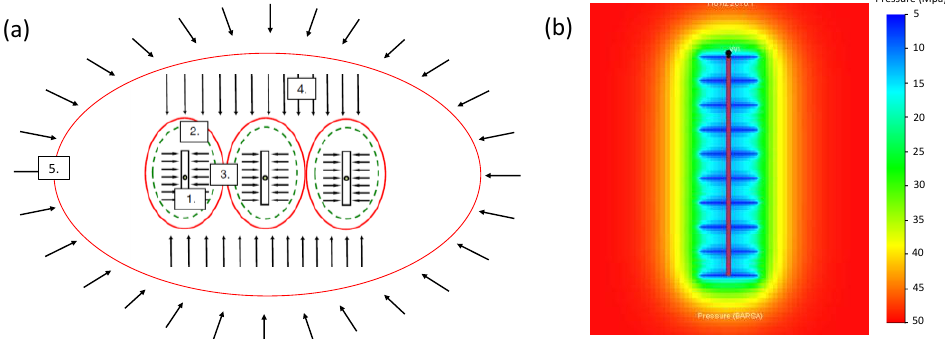
Figure 1. The flow regime characteristics of MHFW, where ( a ) sequence of flow-regimes for a MFHW, completed in a tight sand gas reservoir modified from Clarkson [4]. Lines represent isopotential lines; arrows represent streamlines. Flow-regime 1 corresponds to linear flow; flow-regime 2 corresponds to elliptical flow; flow-regime 3 corresponds to fracture interference; flow-regime 4 corresponds to compound linear, and flow-regime 5 corresponds to compound elliptical flow. ( b ) simulation of flow regimes for a stimulated MFHW in a tight sand gas reservoir. (simulated through numerical simulator).